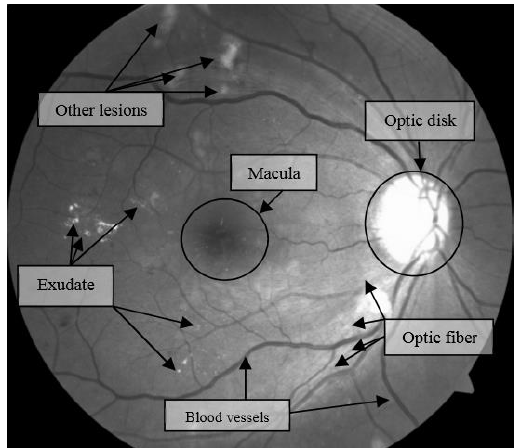
Figure 1. Retina image with anatomical structures and lesions.